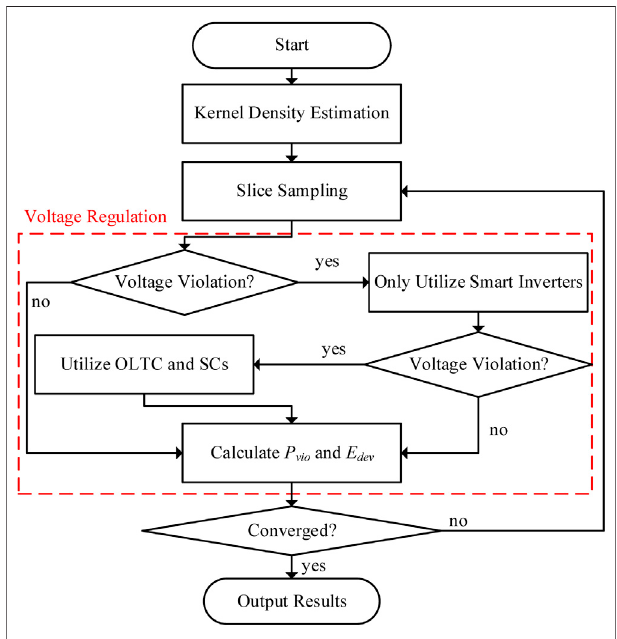
FIGURE 7 | Flow chart of the risk assessment.